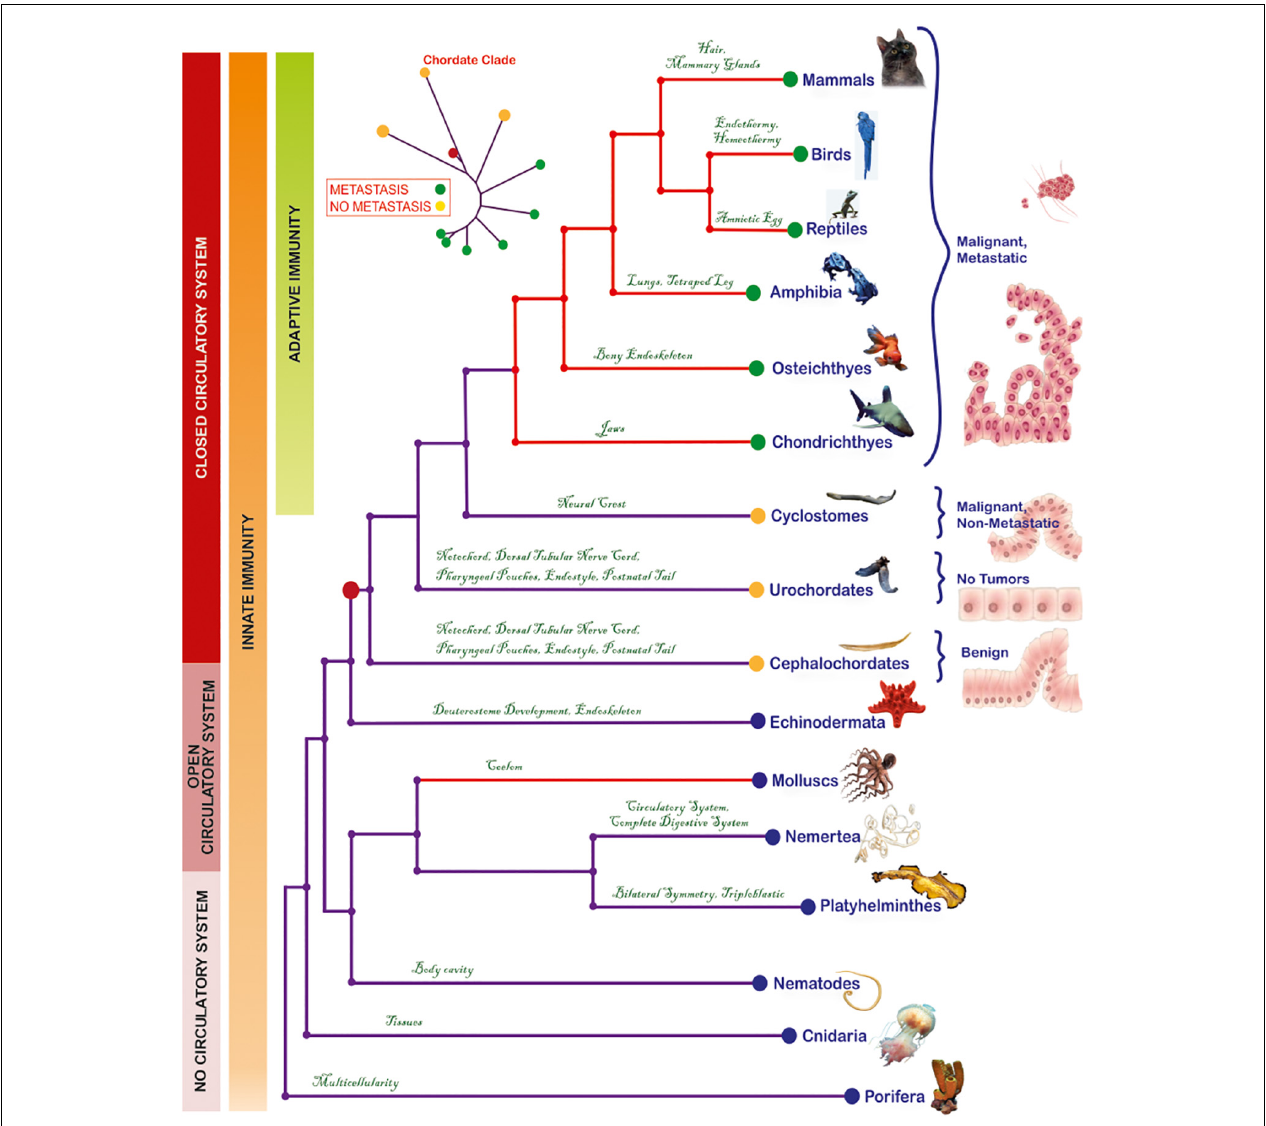
FIGURE 1 | Phylogenetic tree depicting the evolutionary relationships of metazoa and the emergence of metastasis in the cyclostome-to-chondrichthyes transition. Each phylogenetic group has manifested, for the first time, a key innovation that was conserved throughout the lineage. Red-colored clades indicate groups with lethal cancer types. Based on information derived from histological analyses, tumors were classified into benign (corresponding to initiation), malignant/non-metastatic (corresponding to promotion) or malignant, metastatic (corresponding to progression). Invasive and metastatic tumors have been reported from Chondrichthyes to mammals. The mollusks present contagious invasive cancer, while the urochordates are cancer-resistant. The red dot on the tree represents the common chordate ancestor, which gave rise to both, metastatic (green dots) and non-metastatic species (yellow dots). Model of the progression from a normal cell to metastatic cancer was modified from a previous illustration (Iacobuzio-Donahue et al., 2012). The origins of a closed circulatory system and of acquired immunity are also